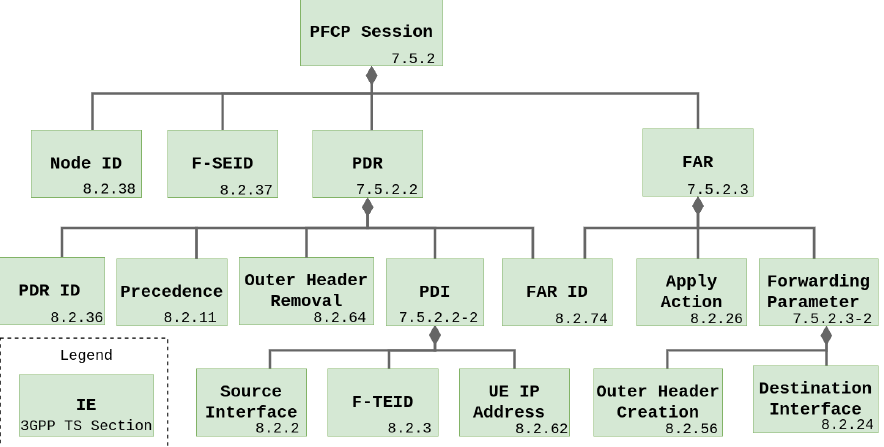
Figure 7. The PFCP context data model of the upf-bpf